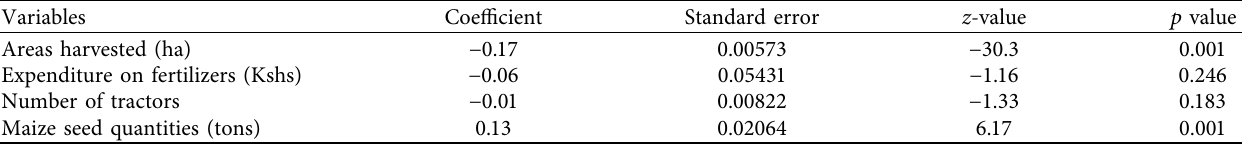
Table 2: Estimates of vector error correction model.